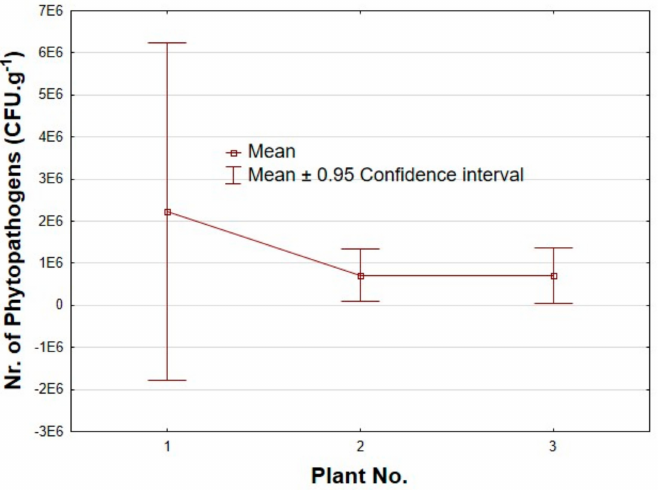
Figure 6. The average number of occurrences of phytopathogens at individual sampling